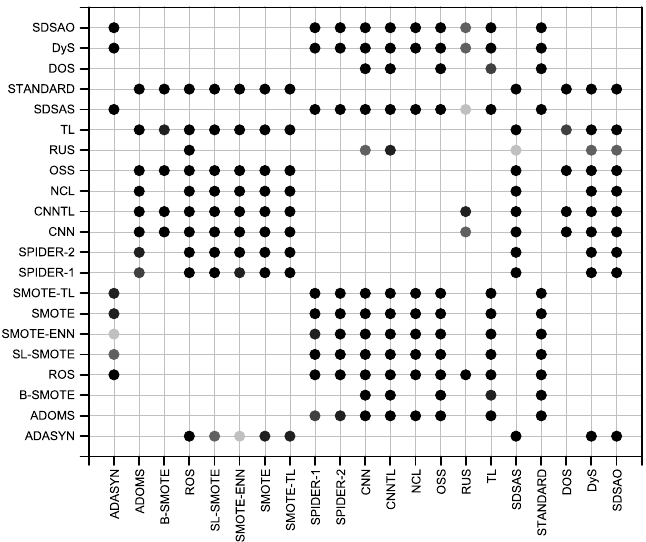
Figure 1. Results of the non-parametric statistical Holm and Shaffer post-hoc test. The fill circles mean that for these particular pairs of classifiers, the null hypothesis was rejected by both test. The color of the circles is the darkest at p -values close to zero, i.e., when the statistical difference is the most